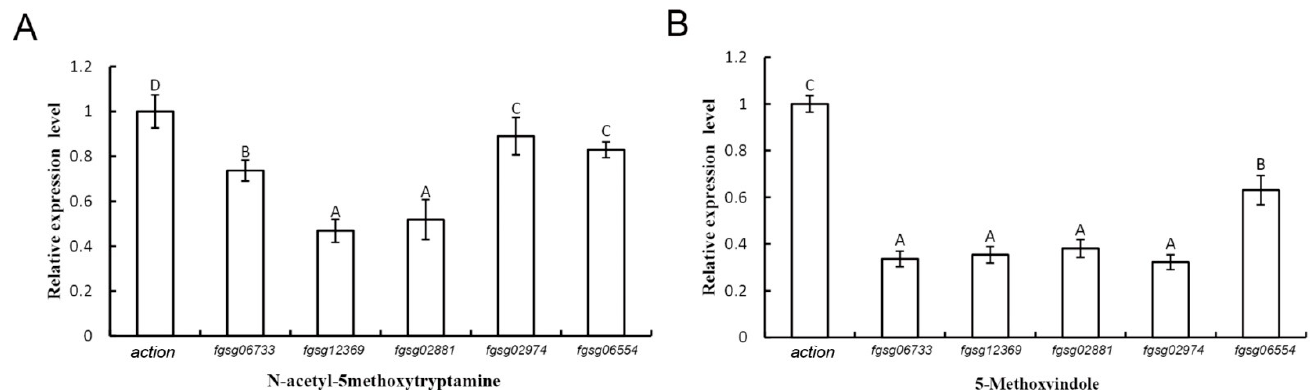
Figure 6. Quantitative real-time PCR analysis of the expression of five genes ( fgsg_02881, fgsg_02974, fgsg_06554, fgsg_06733, and fgsg_12369 ) in F. graminearum PH-1 in response to 4 mM melatonin ( A ) and the 0.1 mM 5-methoxyindole ( B ) treatment. Values were normalized to the levels of the actin gene as an internal reference. The y axis represents the mean expression values standard deviations (SDs), relative to the control. The experiments were repeated independently three times. In all of the experiments, 0.05% (vol/vol) methanol/water served as the ck. The letters above the columns indicate significant